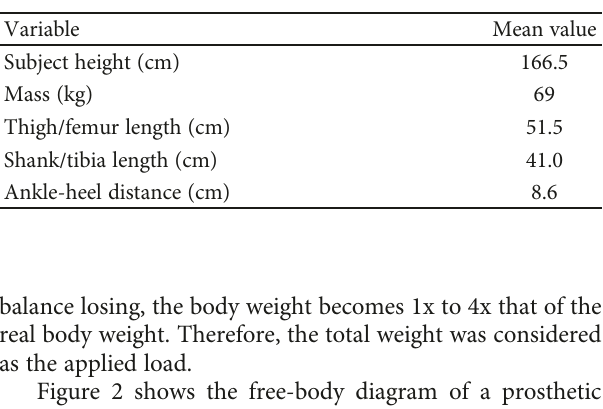
Figure 1: (a) Isometric view and (b) exploded view of the knee joint Table 1: Anthropometrical variables and subject characteristics.